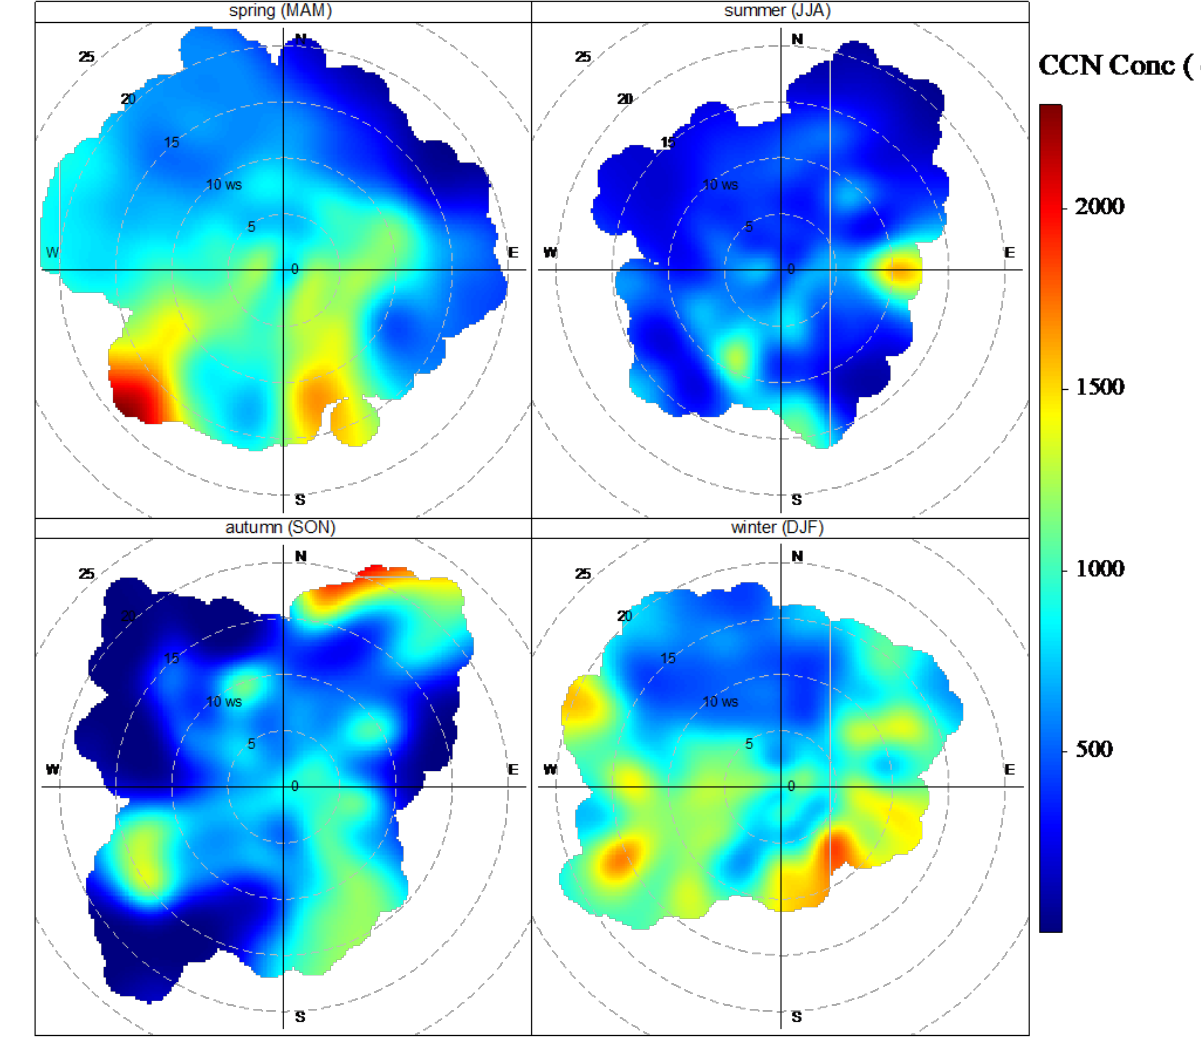
Figure 9. The analysis of potential sources using the CPF approach of CCN from August 2020 to November 2021.